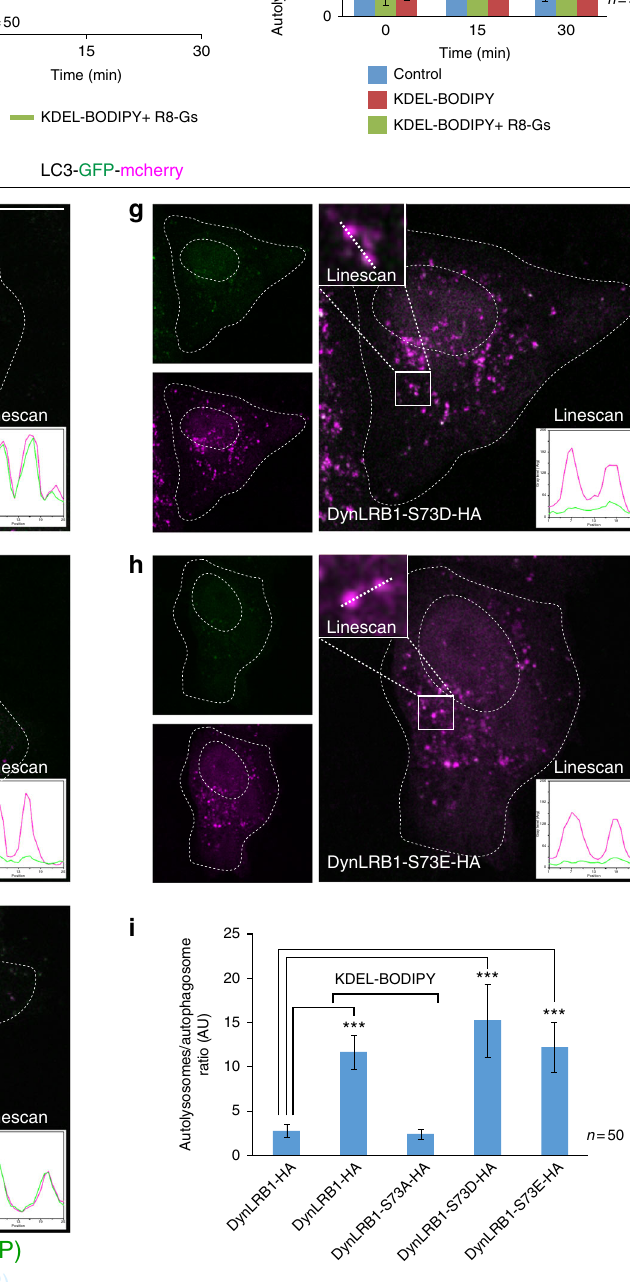
the expression of p62/SQSTM1-S182A (Fig. 7f) greatly impaired IL-2 secretion in T-lymphocytes activated by antigen presenta- tion. These results strongly suggest that the KDELR signalling that triggers lysosome repositioning and activation of autophagy regulates relevant physiological secretion processes such as those that operate in the immune system.